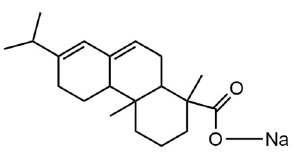
Figure 1. The structural formula of Na-abietate ligand.